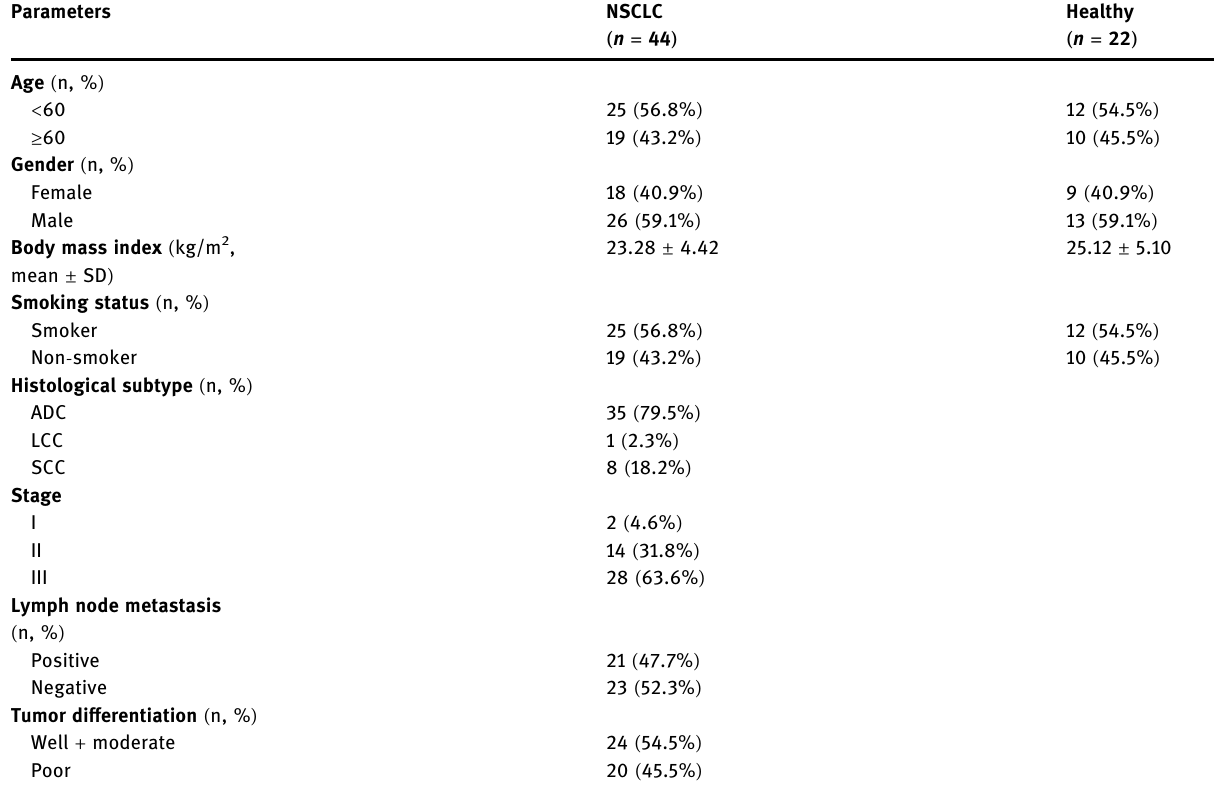
Table A1: Clinicopathological factors of NSCLC patients and healthy